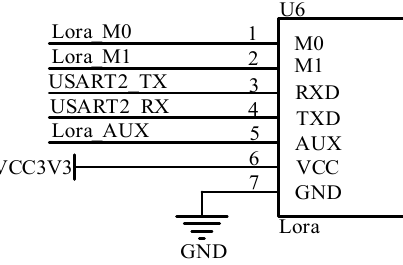
Figure 6. Lora communication circuit.